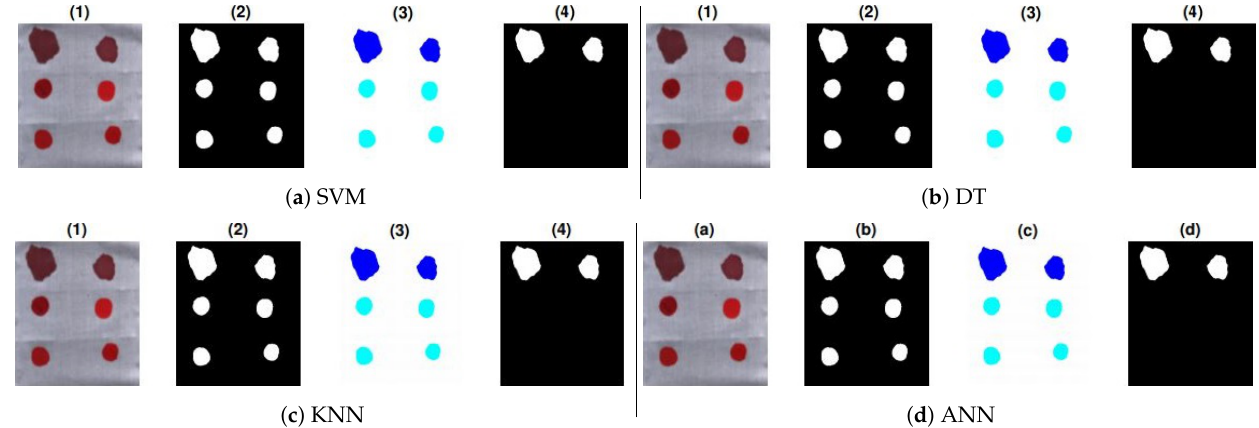
Figure 8. Prediction results of test samples on white fabric: (1) True color image, (2) pre-processed image, (3) labeling, and